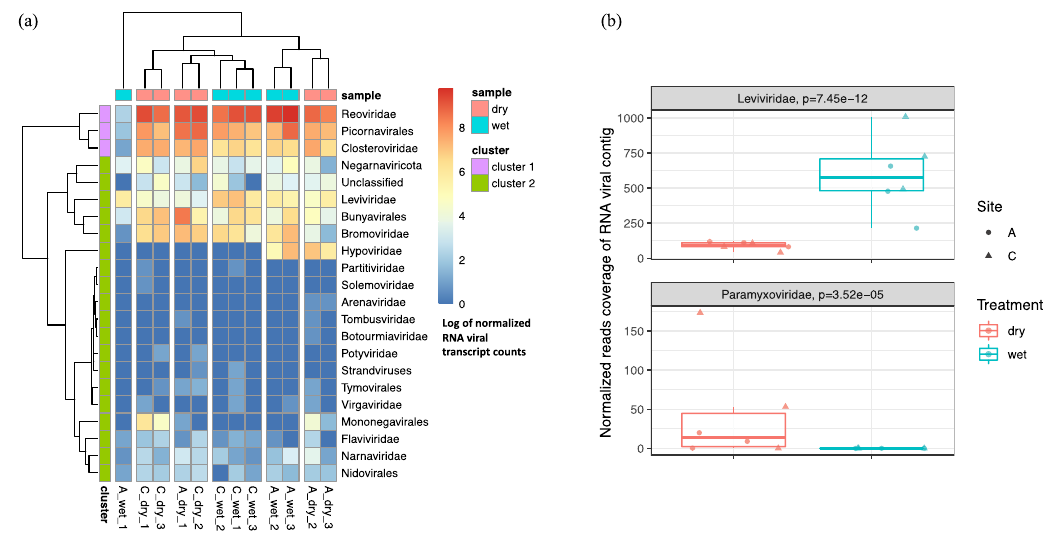
Fig. 5 Composition pro fi ling of the RNA viral community and its abundance shift in response to wet and dry soil treatments. a The RNA viral abundance of each phylogenetic group across all soil samples were summarized and clustered by composition similarity. b Two phylogenetic groups were detected with differential abundances in soils with different moistures (site A, circles; site C, triangles). Signi fi cantly more Leviviridae and signi fi cantly fewer Paramyxoviridae were detected in wet soils (blue) compared to dry (red) soils ( p <